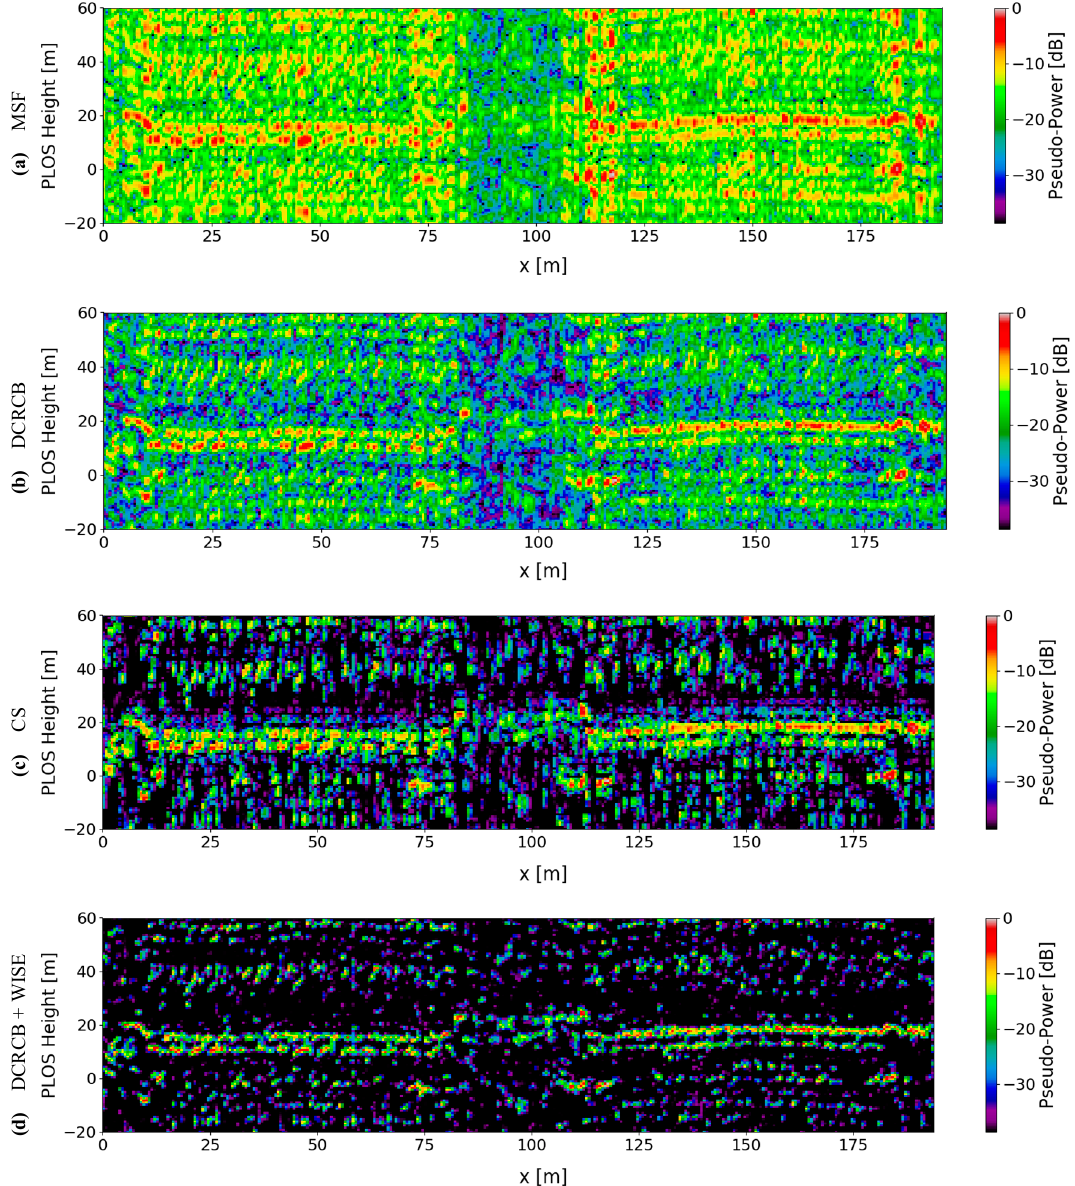
Figure 12. HV tomograms retrieved from the area depicted by the green line crossing the ROI specified in Figure 5. We perform focusing using ( a ) MSF, ( b ) DCRCB, ( c ) CS and ( d ) DCRCB + WISE. We refer to the single-look case. All tomograms are normalized with respect to the (pseudo) power recovered by MSF.